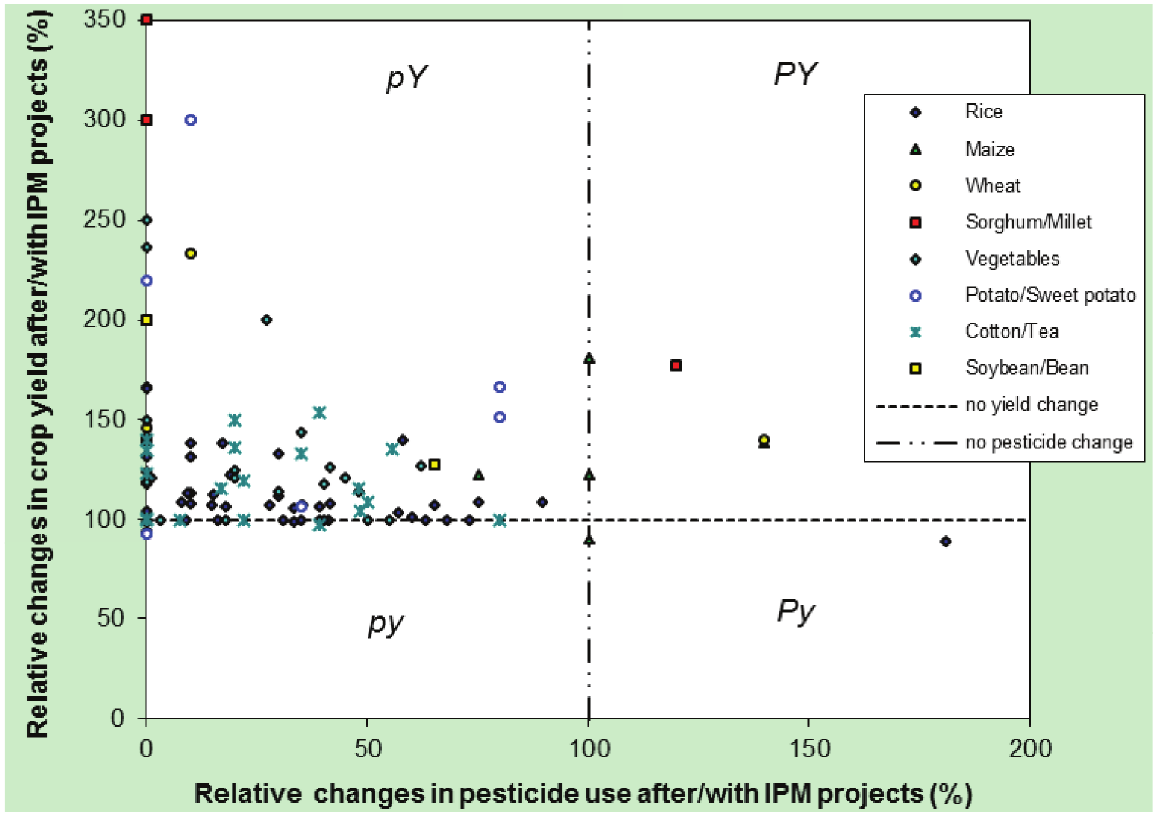
Figure 1. Impacts of IPM projects and programmes on pesticide use and crop yields (data from 115 crop combinations, 85 projects, 24 countries of Africa and